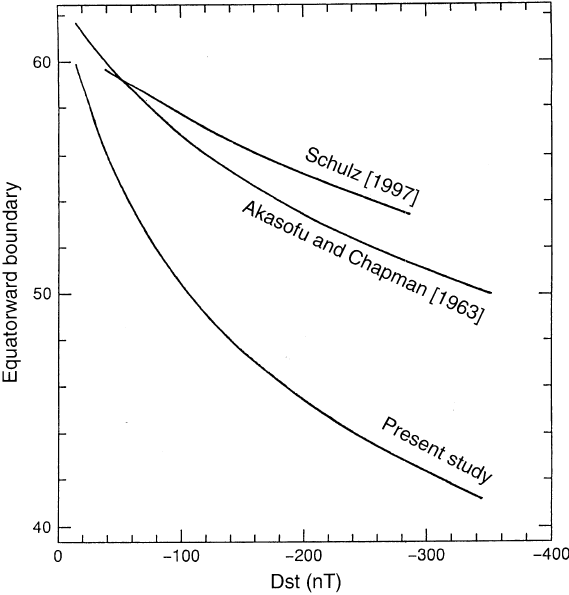
Fig. 7. Three boundaries defined by di(cid:128)erent conditions as functions of Dst : the equatorward boundary of discrete aurora in Akasofu and Chapman (1963), the boundary between open and closed field lines in Schulz (1997), and electron boundary in the present study respective- ly. Schulz’s boundary value is shifted equatorward by 10 (cid:14) because his boundary values are for the poleward